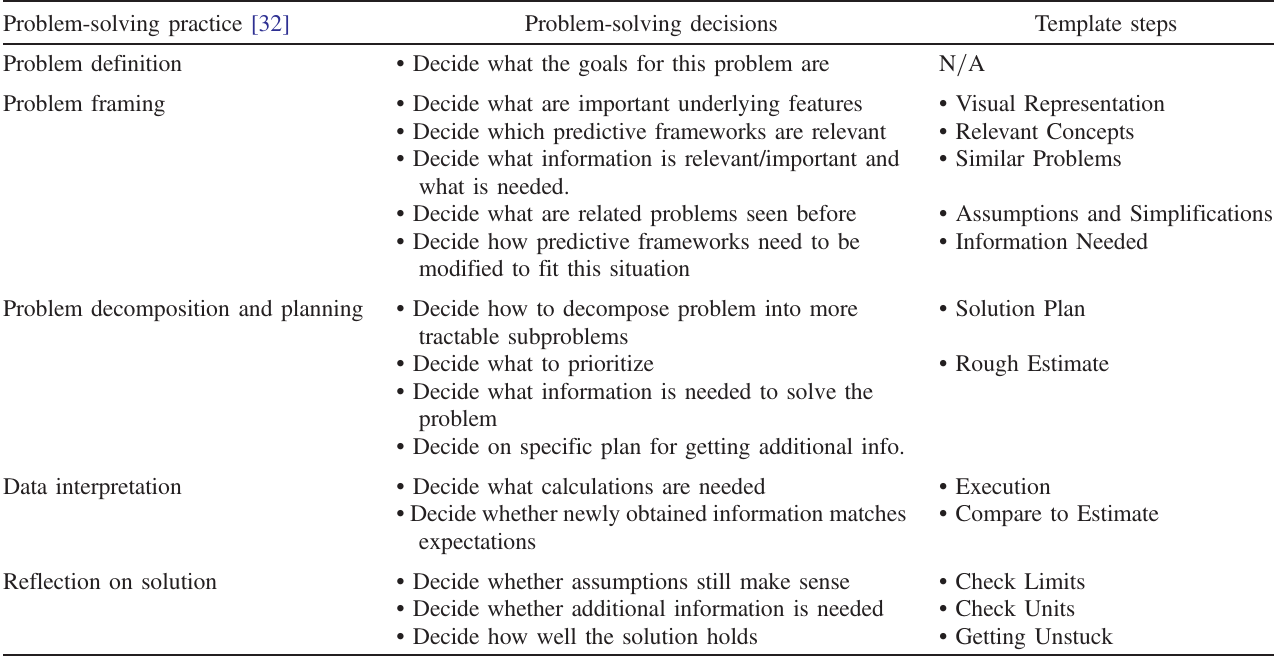
TABLE II. Comparison of problem-solving practice, problem-solving decisions [27], and associated template steps. Problem-solving practice